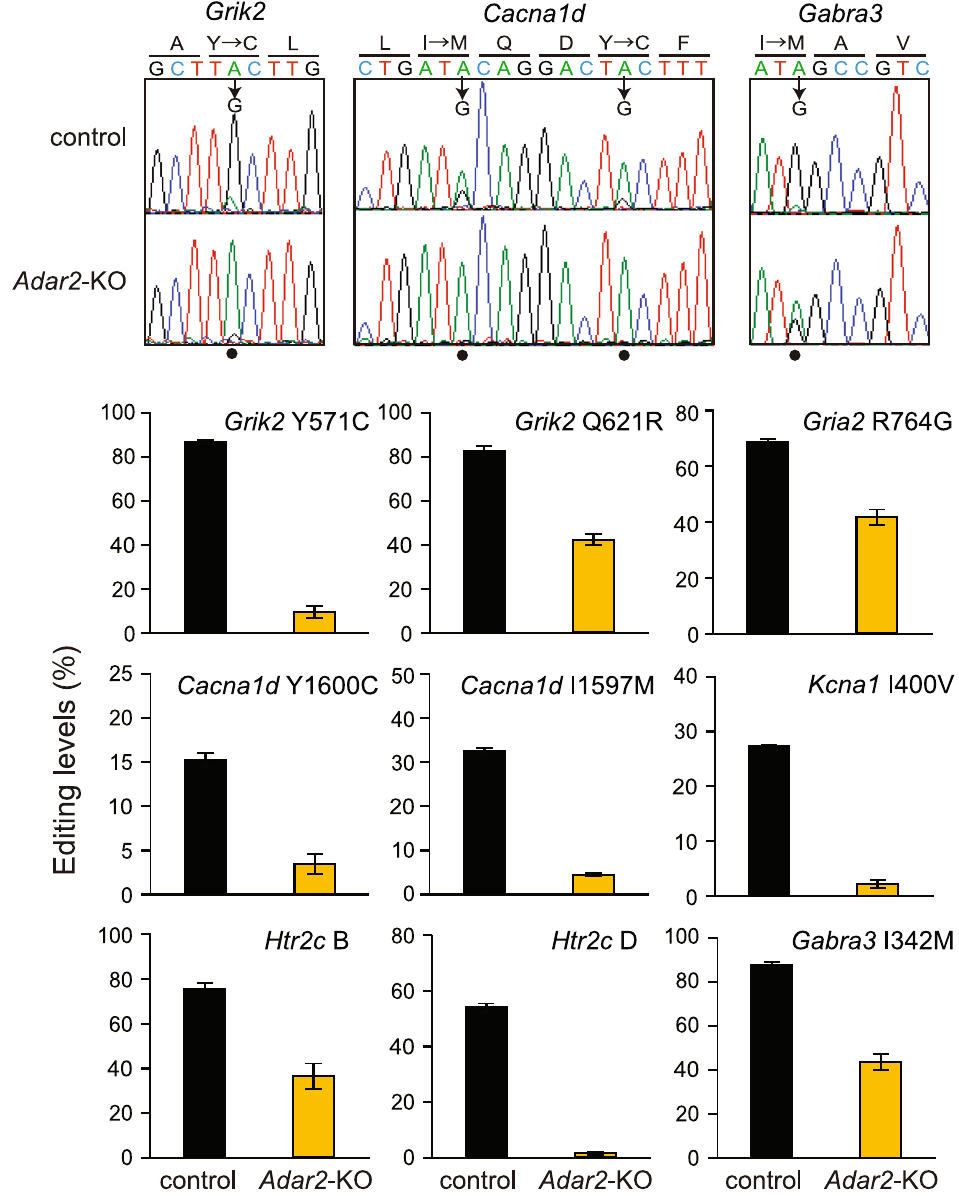
Figure 1. ADAR2-mediated A-to-I RNA editing in mouse SCN. ( a ) Direct sequencing chromatograms from RT-PCR products in control (top) and Adar2 -KO (bottom) mouse SCN at CT22. The solid circles indicate the editing sites in the transcripts. ( b ) A-to-I RNA editing level at each editing sites in direct sequencing analysis (mean ± s.e.m.; n =